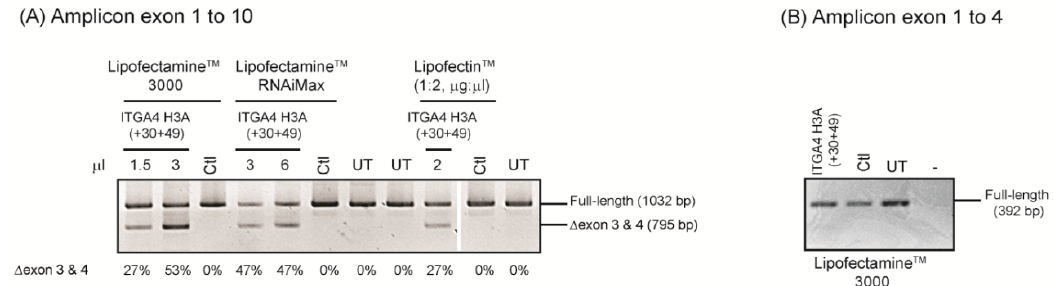
Figure 3. Modification of integrin alpha 4 ( ITGA4) transcripts after healthy human fibroblasts were transfected with different lipid-based transfection reagents. ( A ) Three lipid-based reagents were used to transfect cells with ITGA4 H3A ( + 30 + 39) at 100 nM for 24 hr. Total RNA was extracted and RT-PCR was undertaken across exons 1 to 10 of the ITGA4 transcripts. Transfection reagent volumes are indicated above the gel. Ctl; control AO that does not anneal to any sequence, UT; untreated, -; no template control. Percentages of ITGA4 exon 3 and 4 skipping are indicated below the gel. The control AO was transfected using the maximum volume of transfection reagents. ( B ) RT-PCR amplification of the ITGA4 transcript across exons 1 to 4 from RNA extracted from sample transfected with Lipofectamine 3000 from ( A ).